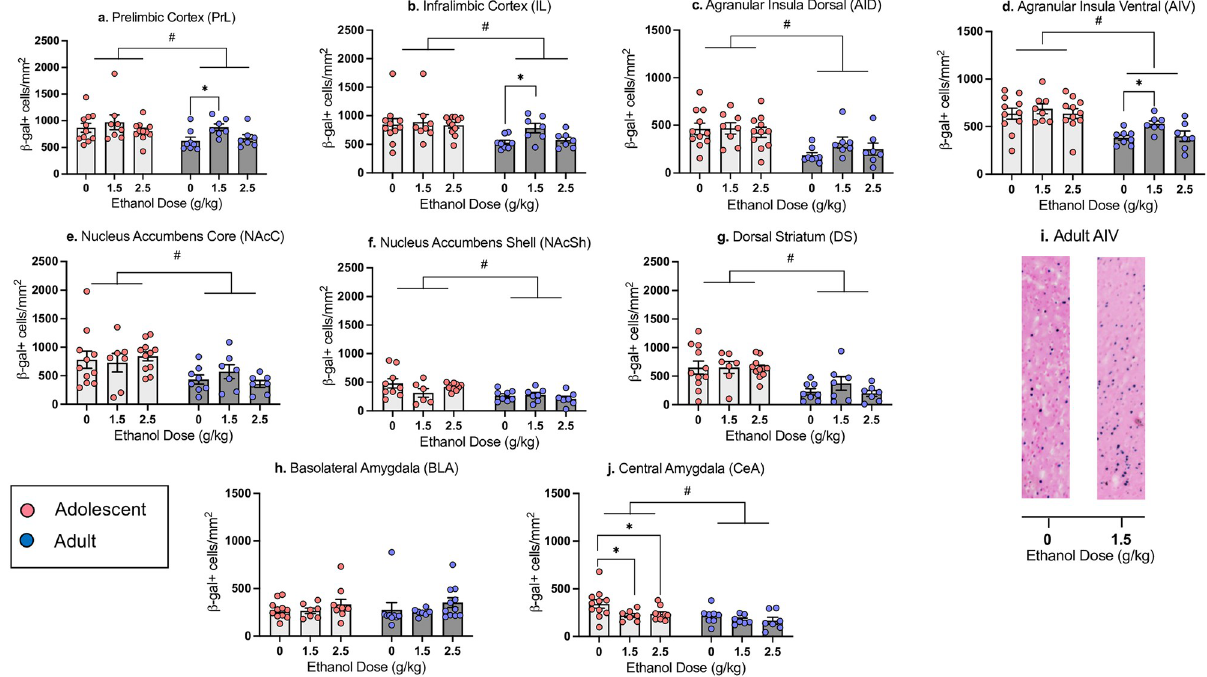
Fig 2. Neuronal activation indexed via number of β -gal+ cells in adolescents and adults. β -gal+ cell counts in the Prelimbic Cortex (a), Infralimbic Cortex (b), Dorsal Agranular Insular Cortex (c), Ventral Agranular Insular Cortex (d), Nucleus Accumbens Core (e), Nucleus Accumbens Shell (f), Dorsal Striatum (g), Basolateral Amygdala (h), and Central Amygdala (j) in adolescent and adult males previously conditioned with 0, 1.5 or 2.5 g/kg ethanol on test day following exposure to the CS (NaCl). (i) Images of β -gal+ cells in AIV of adult rats, 1mm in length. n = 7-11/group; # denotes main effect of age, asterisks ( � ) mark significant ethanol-associated changes relative to controls conditioned with with saline (0 g/kg ethanol dose) within each Age (p < 0.05).